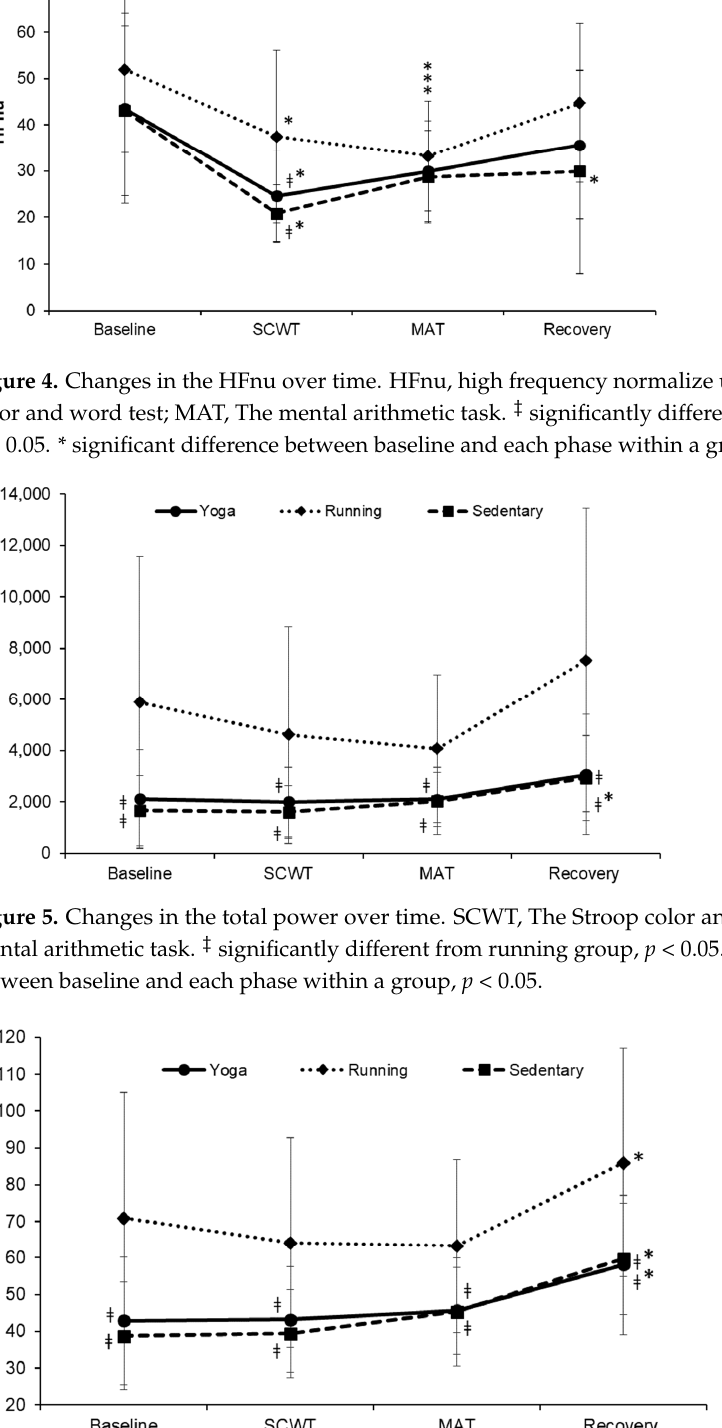
Figure 6. Changes in the SDNN over time. SDNN, standard deviation of normal-to-normal intervals;